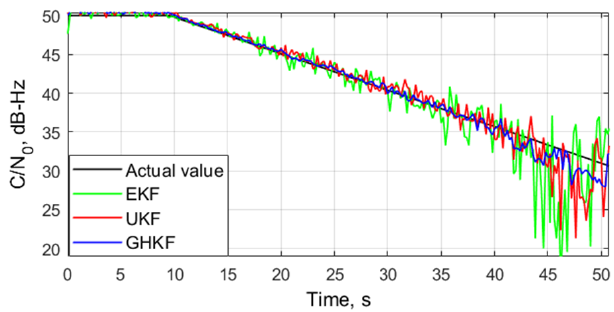
/ C N estimates. Figure 5. C / N 0 estimates. Figure 5. 0